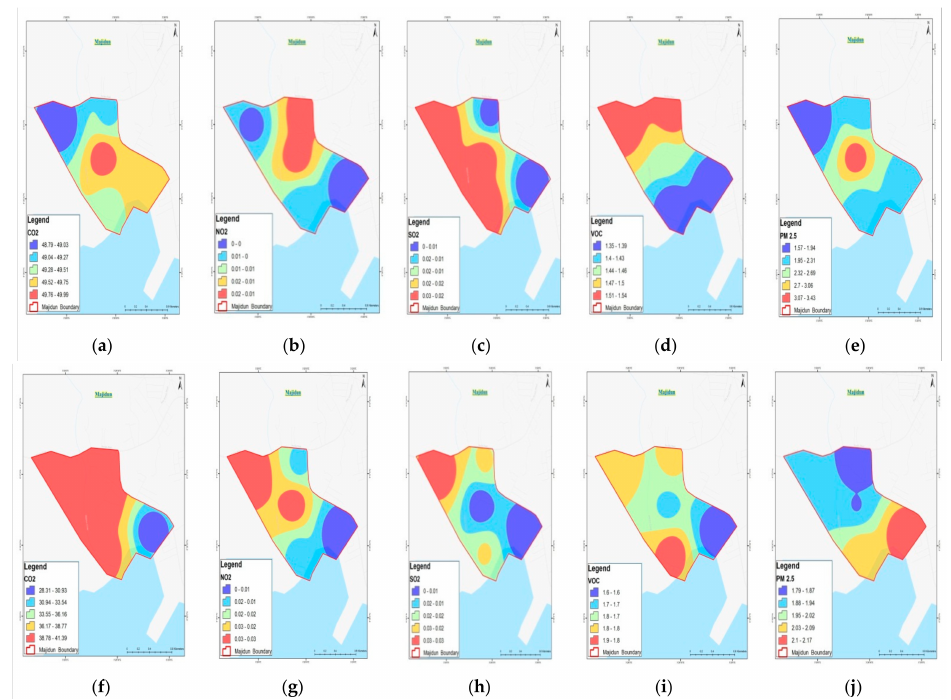
Figure 6. Spatial pattern of the air pollutant concentration from the Majidun slum settlement (2018 to 2019) during the wet and dry seasons. The magnitude of the pollution is identified with different colors on the map, which signify areas with hot and cold spots. ( a )CO 2 mg/m 3 Dry; ( b ) NO 2 mg/m 3 Dry; ( c ) SO 2 mg/m 3 Dry; ( d ) VOC mg/m 3 Dry; ( e ) PM 2.5 µ g/m 3 Dry;